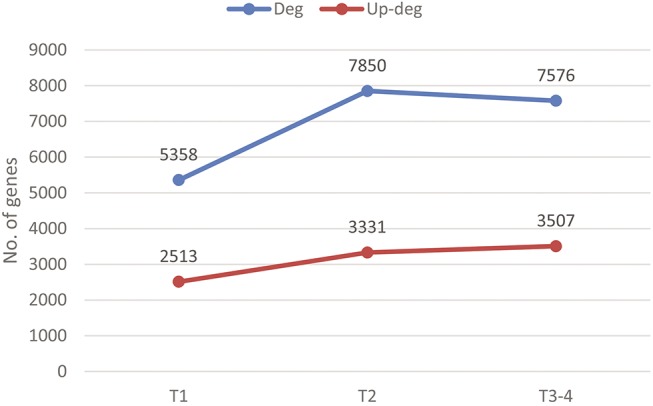
Cancer stages versus the number of differentially expressed genes.The blue and red lines are for the numbers of differentially expressed and up-regulated genes, respectively, across the three stages.